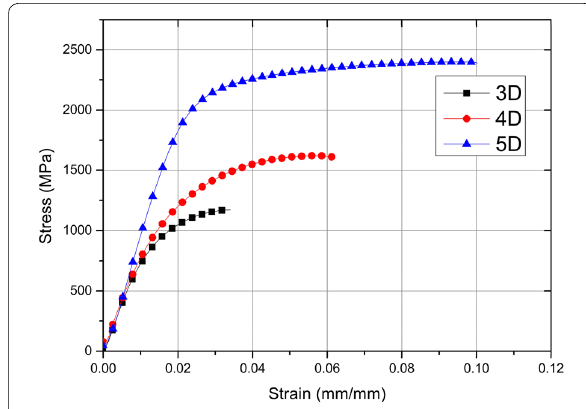
Fig. 2 Stress–strain curves from fibres tensile